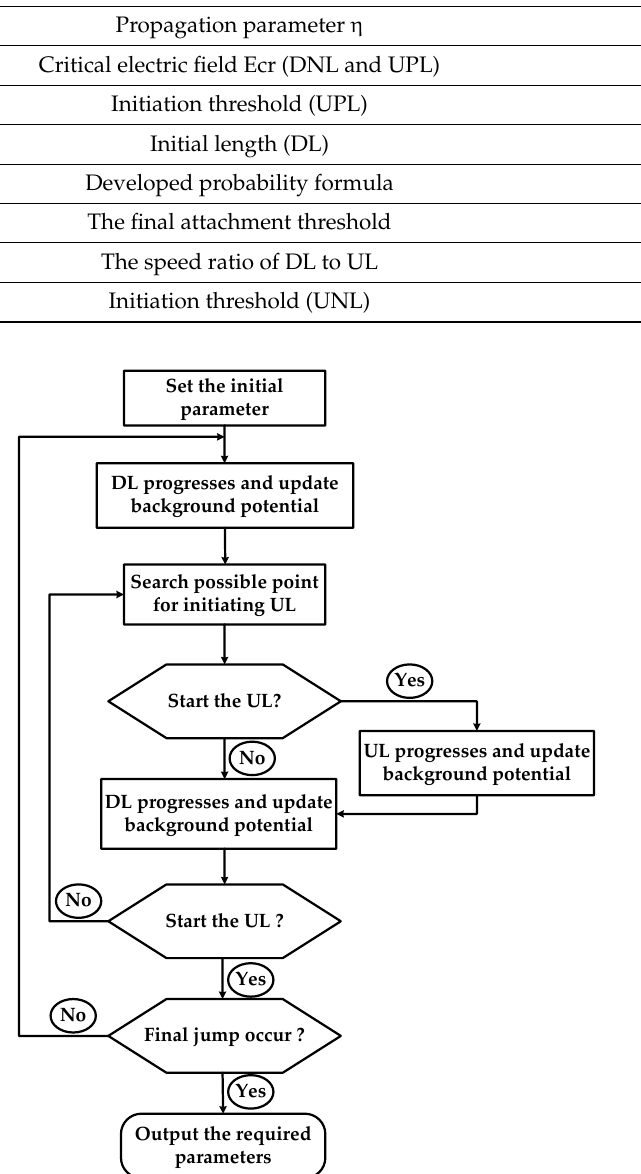
Figure 2. Flow diagram of the model for multiple leaders’ development.